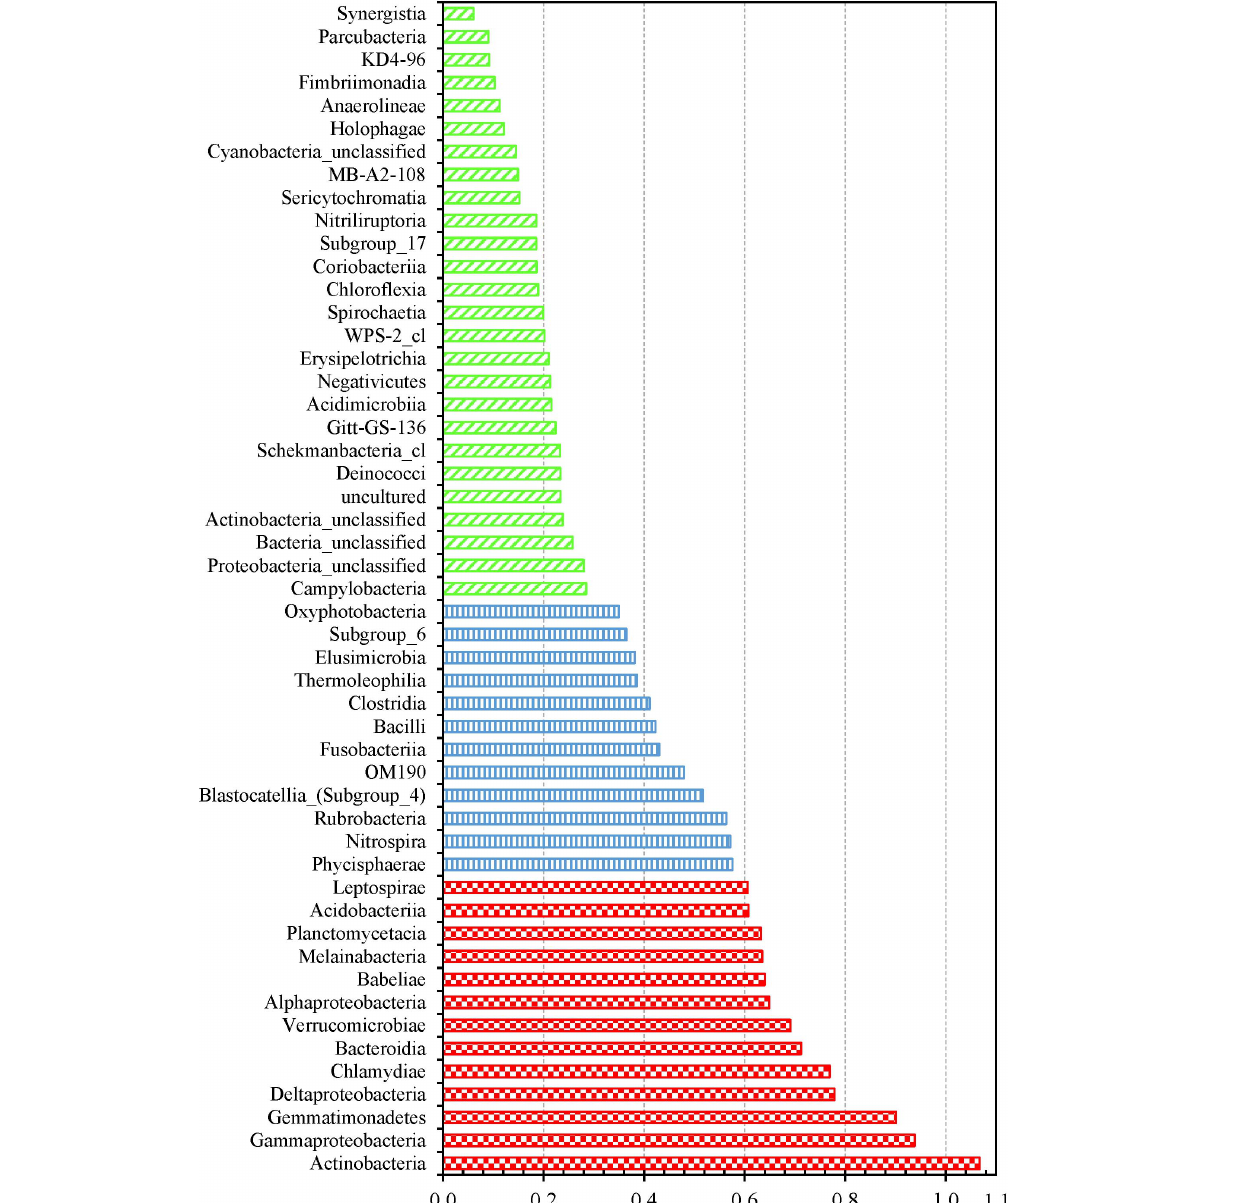
temperature ( Supplementary Figure 11 ), the multiple linear regression reveals that for the “pooled” water samples (e.g., mixed datapoints for all 96 water samples), the Inverse Simpson diversity index significantly increased with water temperature ( Table 1 ) although the Inverse Simpson diversity index of hot tap water was lower than those of cold tap and shower water. Third, water temperatures of some first draw samples of hot